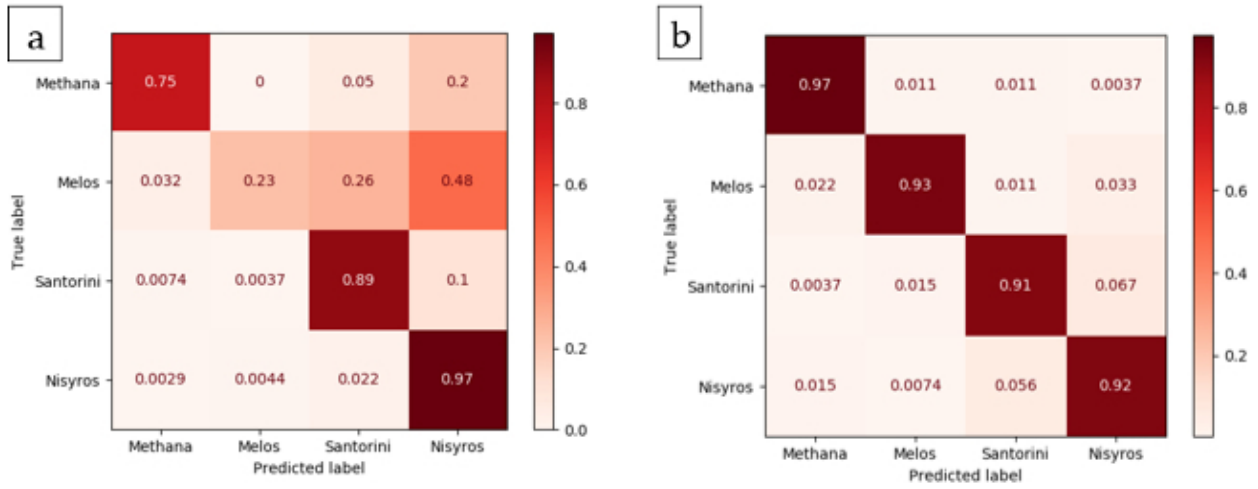
Figure 11. Confusion matrix of ( a ) Model 6 and ( b ) Model 6 with the augmented Dataset 5—balanced 900.